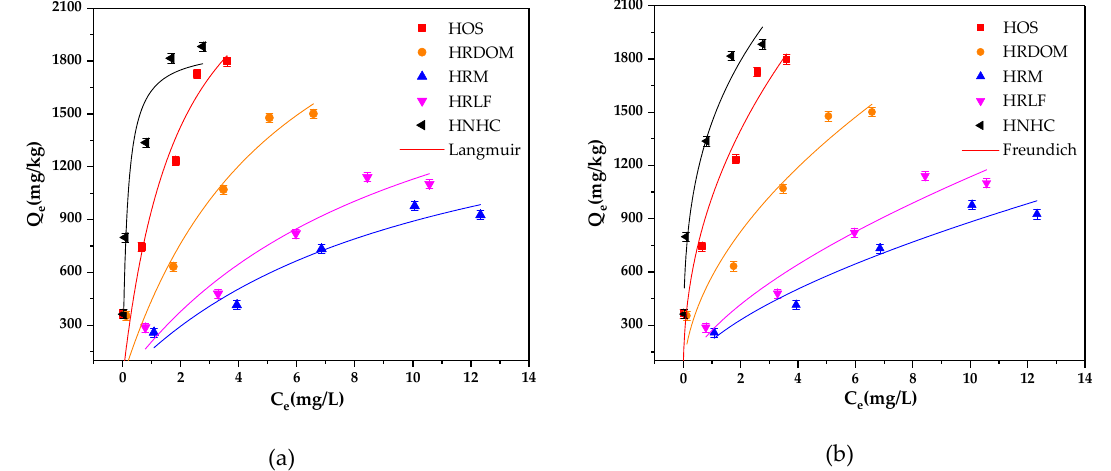
Figure 3. The fitted adsorption isotherms of OTC by different fractions: ( a ) Langmuir model; ( b ) Freundlich model. Table 4. The fitted parameters for Langmuir isotherm model and Freundlich isotherm model.